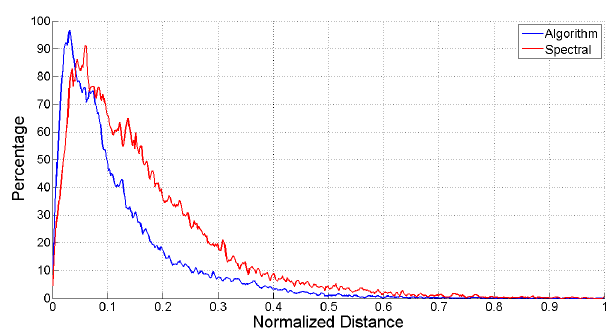
Figure 6. Vertex distance distributions for algorithm (blue) and spectral (red) vertices, as compared to a manual control data set, normalized to the maximum